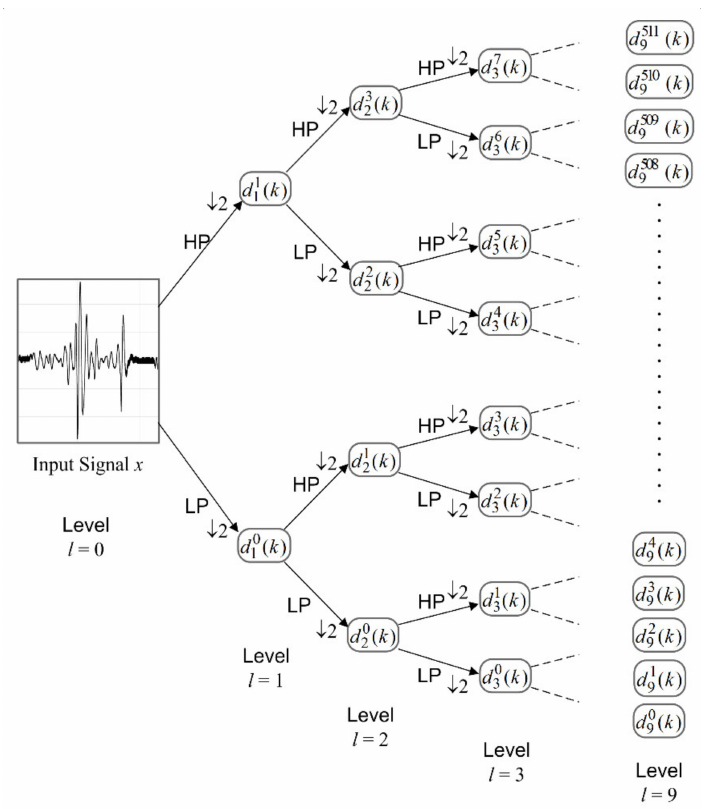
Figure 3. WPT (Wavelet Packet Transform) tree structure, indicating levels, ordinal indices at each level and terminal nodes. The down arrow “ ↓ n” indicates a down sampling (or decimation) by a factor of n (in our case, n =